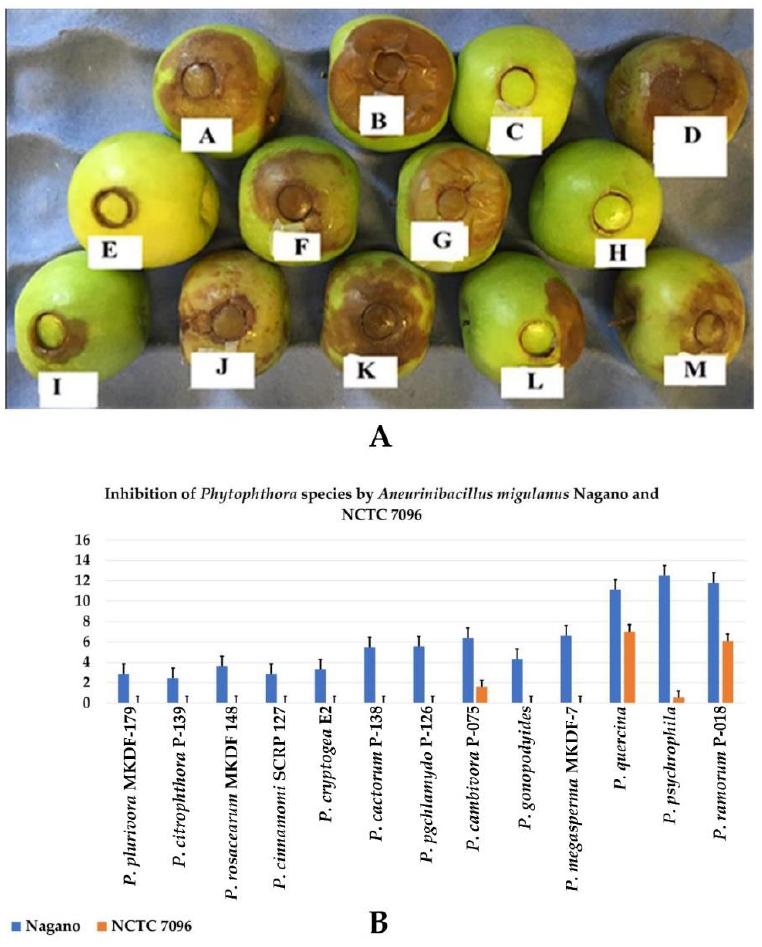
Figure 2. ( A ) In vivo pathogenicity assay of Phytophthora species on apple fruits; (A) P. cryptogea E2, (B) P. rosacearum MKDF-148, (C) P. quercina , (D) P. plurivora MKDF-179, (E) P. cinnamomi SCRP 127, (F) P. cambivora P-075, (G) P. taxon Pgchlamydo P-126, (H) P. psychrophila , (I) P. megasperma MKDF-7, (J) P. citrophthora P-139, (K) P. cactorum P-138, (L) P. gonapodyides, (M) P. ramorum P-018 (7 days after